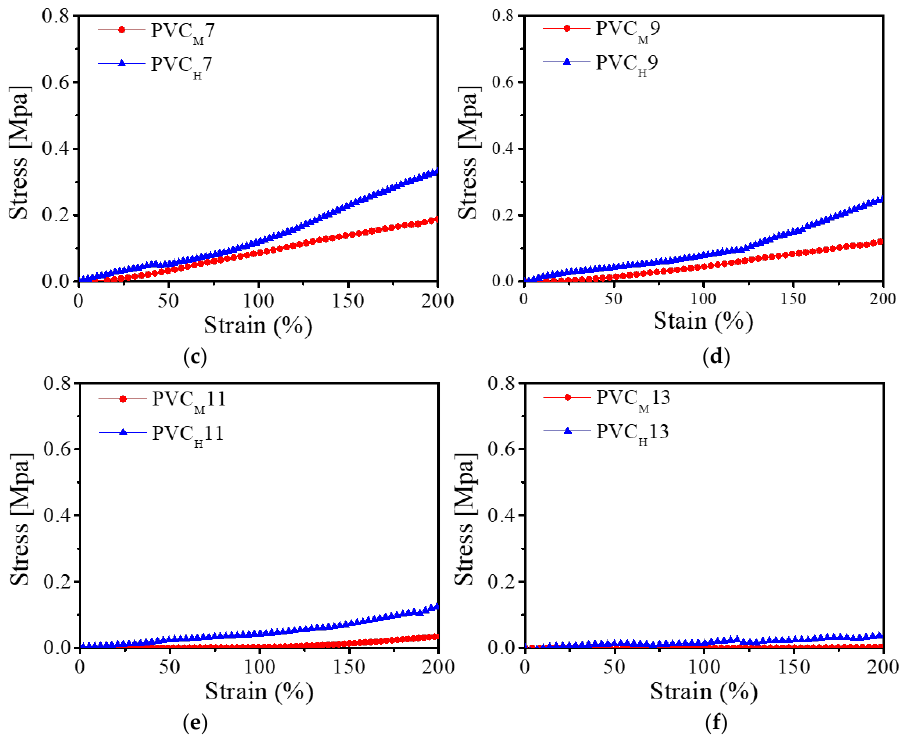
Figure 5. Experimental results for the mechanical properties of the PVC gels: different molecular weights of PVC with the weight ratio of PVC to DBA plasticizer of ( a ) 1:3, ( b ) 1:5, ( c ) 1:7, ( d ) 1:9, ( e ) 1:11, and ( f ) 1:13.